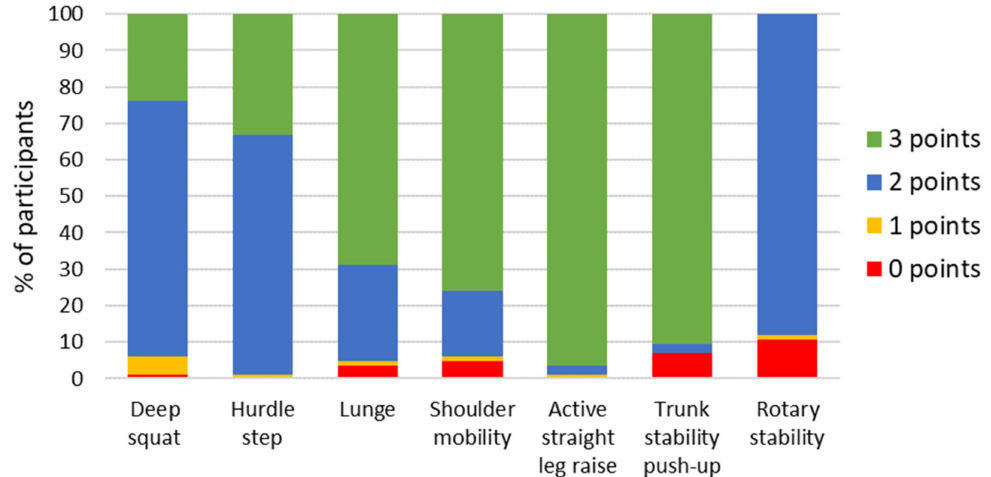
Figure 1. The frequency of FMS scores across the 7 tests (0–3 points).